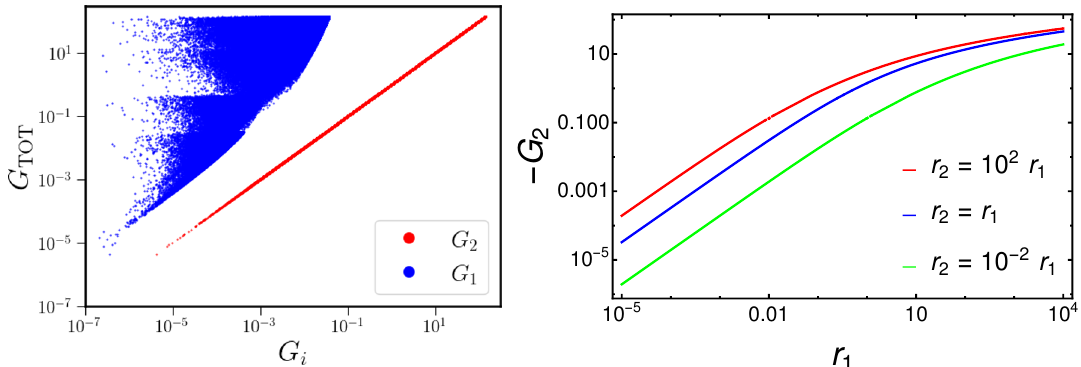
Figure 2. Left: integral function G TOT = G 1 + G 2 vs G i ( i = 1 , 2) . Right: contribution from G 2 ( r 1 , r 2 ) as a function of mass ratio r 1 for three different choices r 2 = 100 r 1 (red), r 2 = r 1 (blue), and r 2 = 0 . 01 r 1